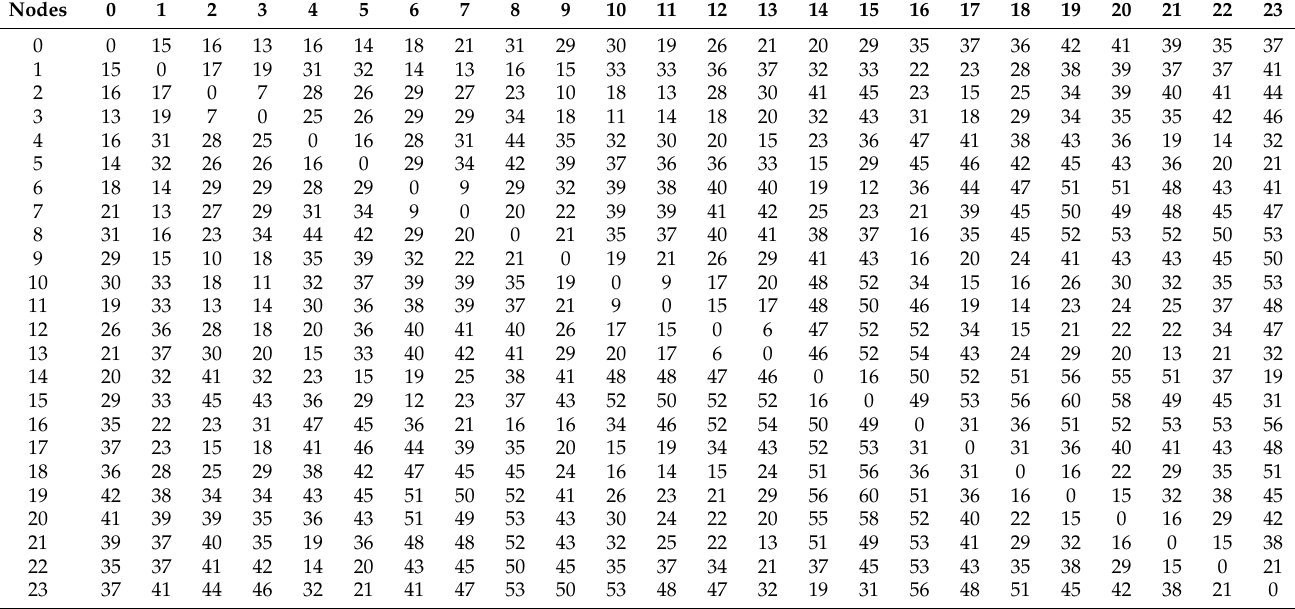
Figure 3. Flow chart of tabu search algorithm. Table 1. Distance between nodes.